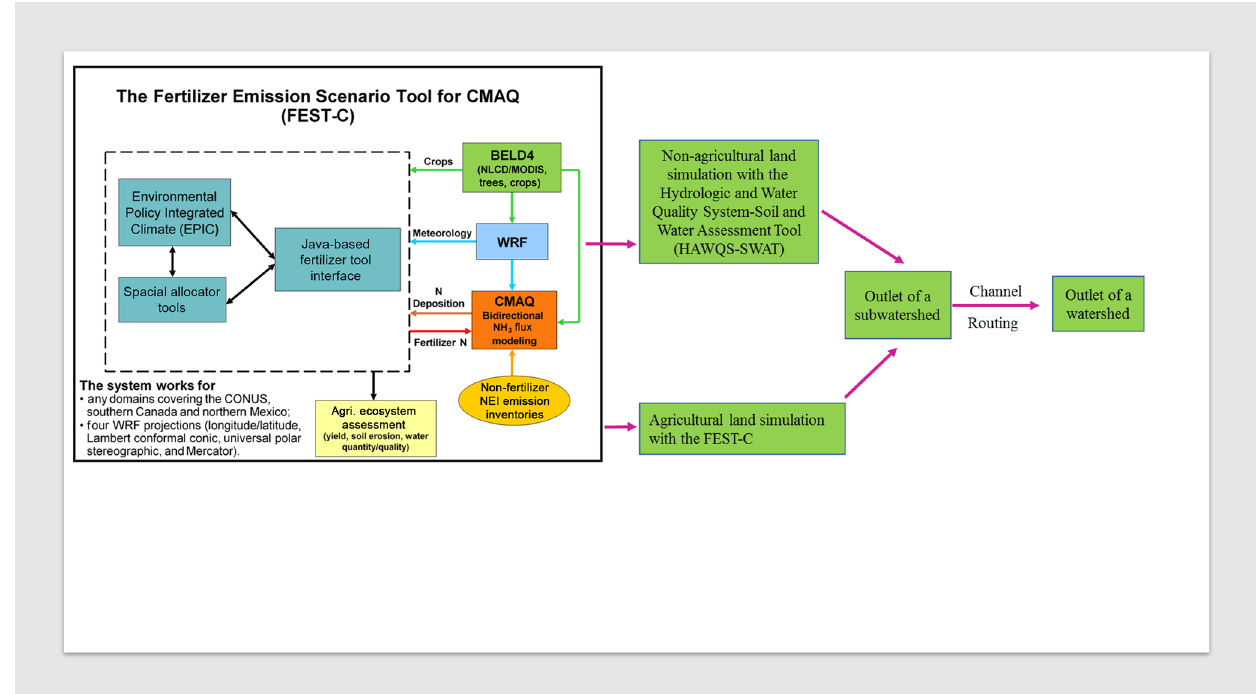
Figure 1. Integration of FEST-C (EPIC/WRF/CMAQ) and SWAT: EPIC was used to simulate agricultural land because of its complexity in simulating agricultural production and related pollutant loadings, as well as its interaction with CMAQ and WRF. HAWQS-SWAT simulates non-agricultural land and takes in FEST-C output from agricultural land at an outlet of a subwatershed, then simulates stream and channel processes, and routes combined loadings to the